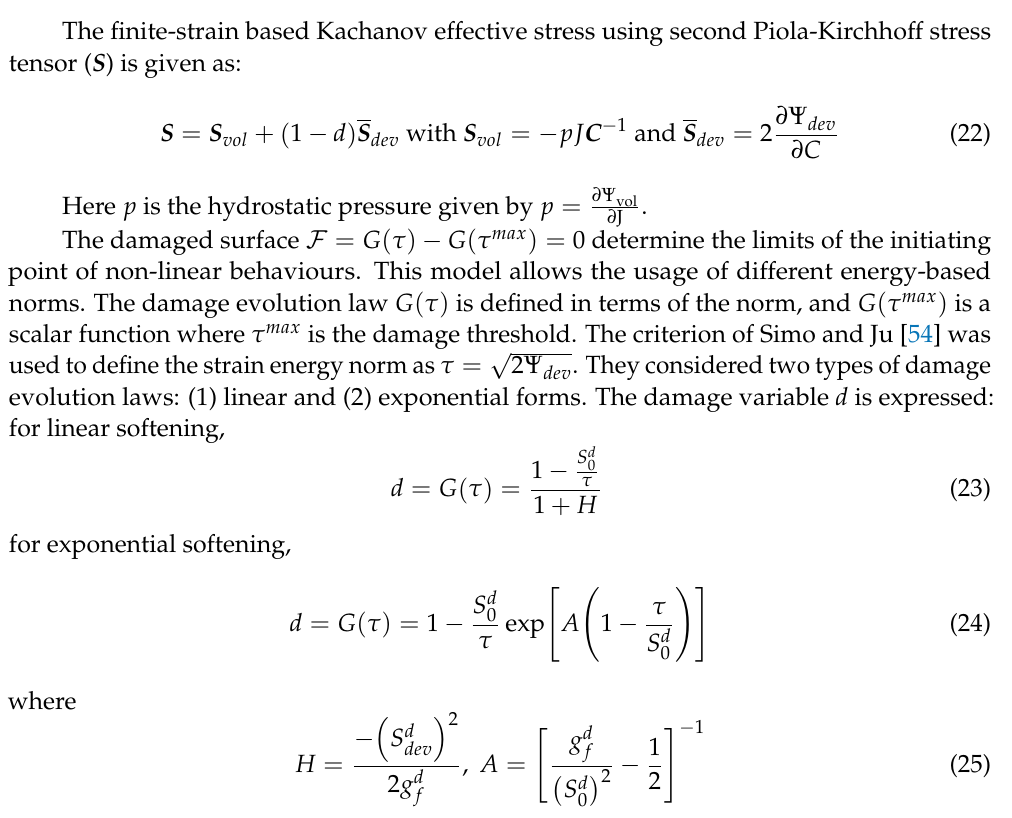
Figure 5. The hierarchical soft tissue model considered by Blanco et al. [64], Reprinted with permis- sion from ref. [64], Copyright 2015